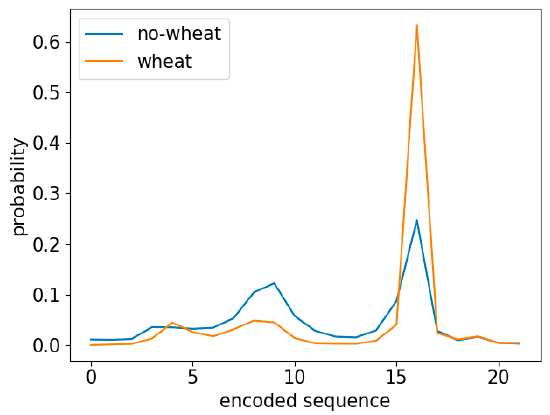
Figure 10. The mean probability distribution that the target class is aligned with the encoded sequence.